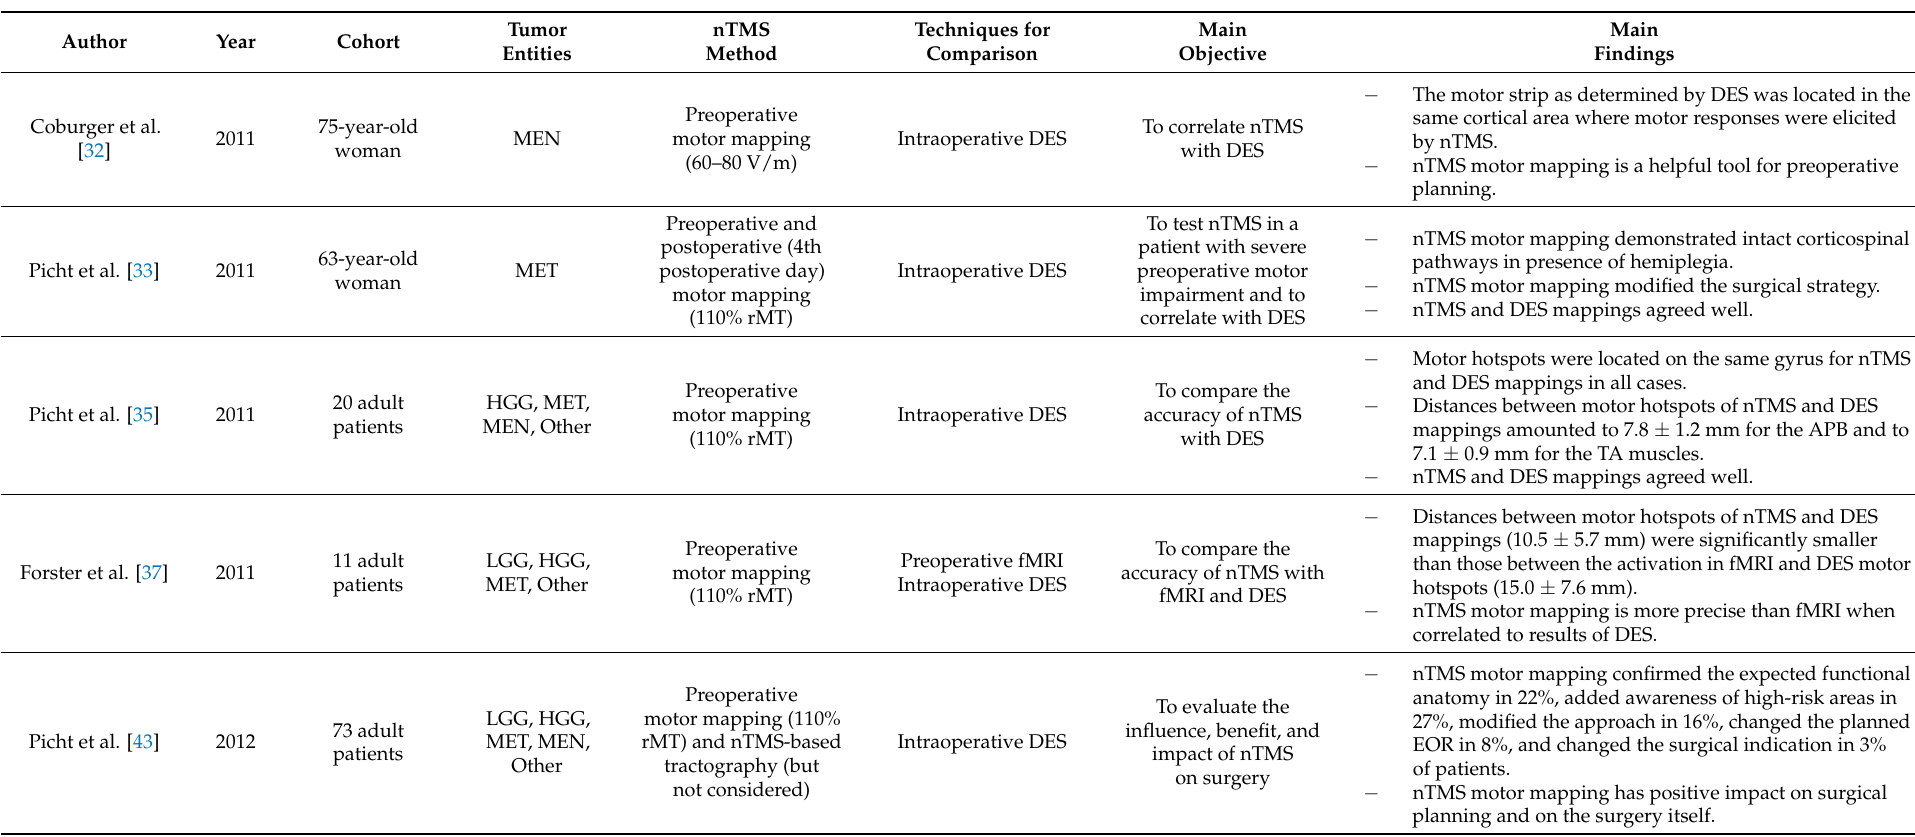
Table 1. Feasibility, reliability, and comparison with other methods. This table outlines the studies published on feasibility and reliability of motor mapping by nTMS (using an electric-field-navigated system) in patients harboring brain neoplasms. Furthermore, studies comparing nTMS motor mapping with other modalities (intraoperative DES, preoperative fMRI, and preoperative MEG) are